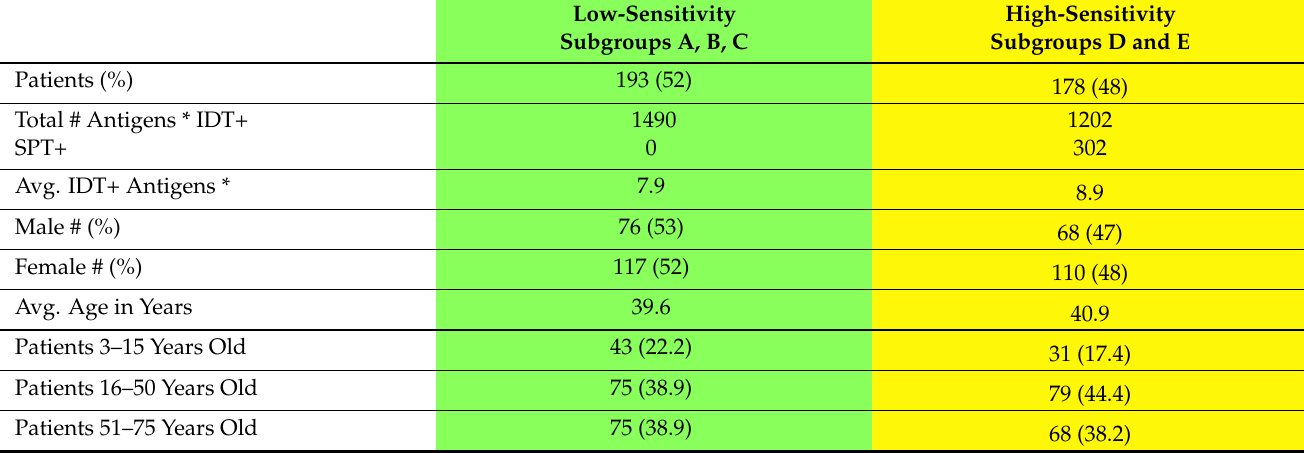
Table 2. Demographics of patients with positive IDT and either negative or positive